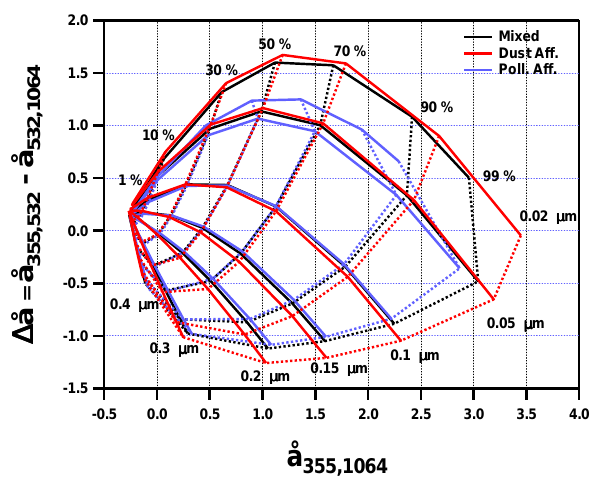
Fig. 1. Graphical framework for the aerosol characterization cal- culated according to Gobbi et al. (2007) for n = 1.455 and k = 0.0047 (black lines), n c = 1.483 and k c = 0.0035 (red lines), and n f = 1.445 and k f = 0.0070 (blue lines) at 7